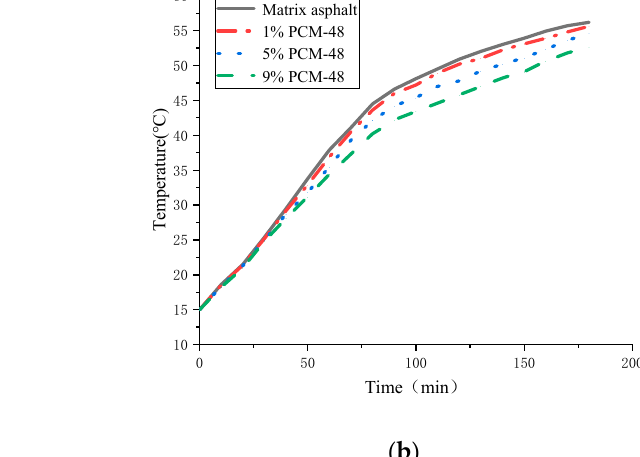
Figure 8. Temperature adjustment performance of PCM asphalt: ( a ) PCM-43; ( b ) PCM-48.